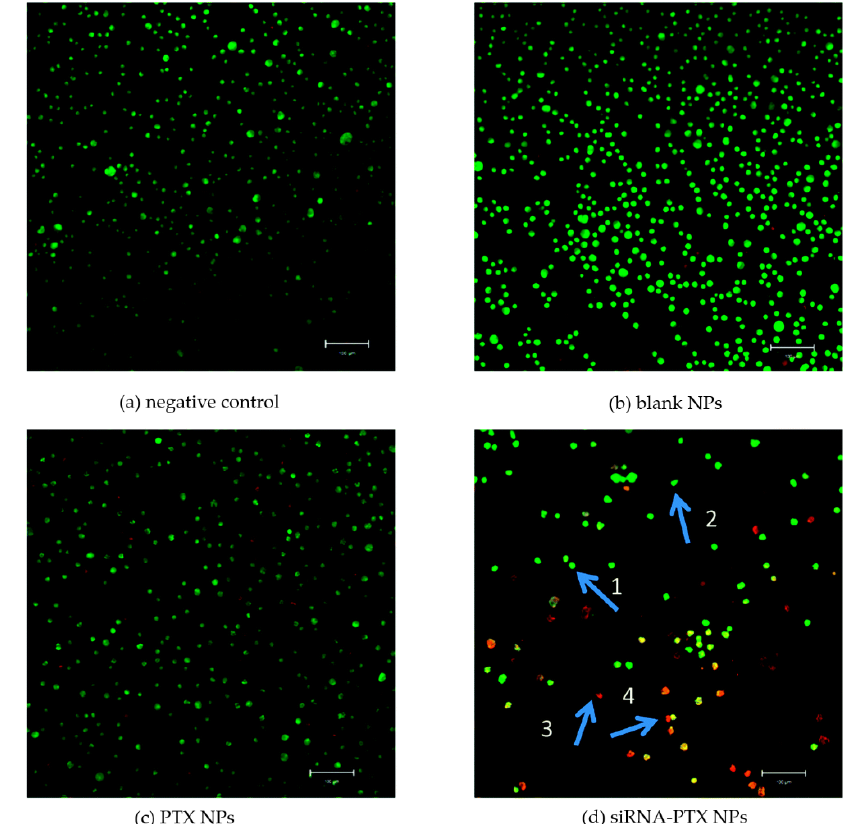
Figure 4. Antitumor activity of siRNA-paclitaxel NPs measured by AO/EB assay. Arrow 1 for the green round, arrow 2 for the green irregular, arrow 3 for the orange irregular, and arrow 4 for the orange round. Adapted with permission from [81] . Copyright © 2022 The Royal Society of Chemistry.